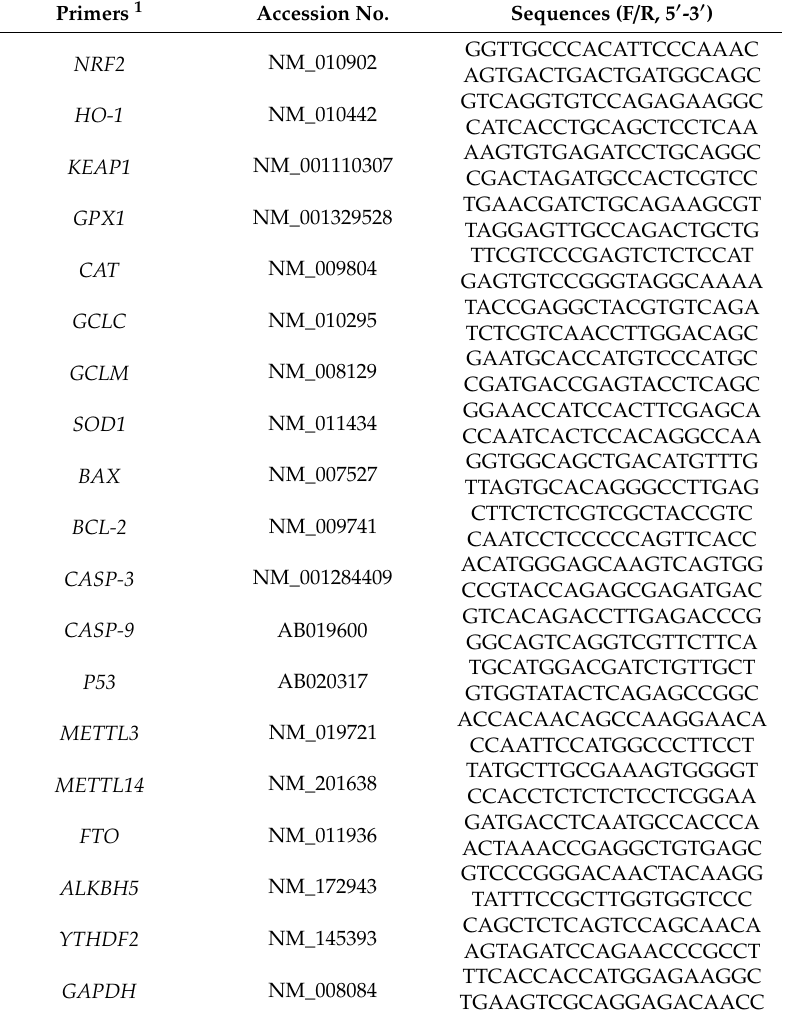
Table 1. Primer sequences used for quantitative real-time PCR in this